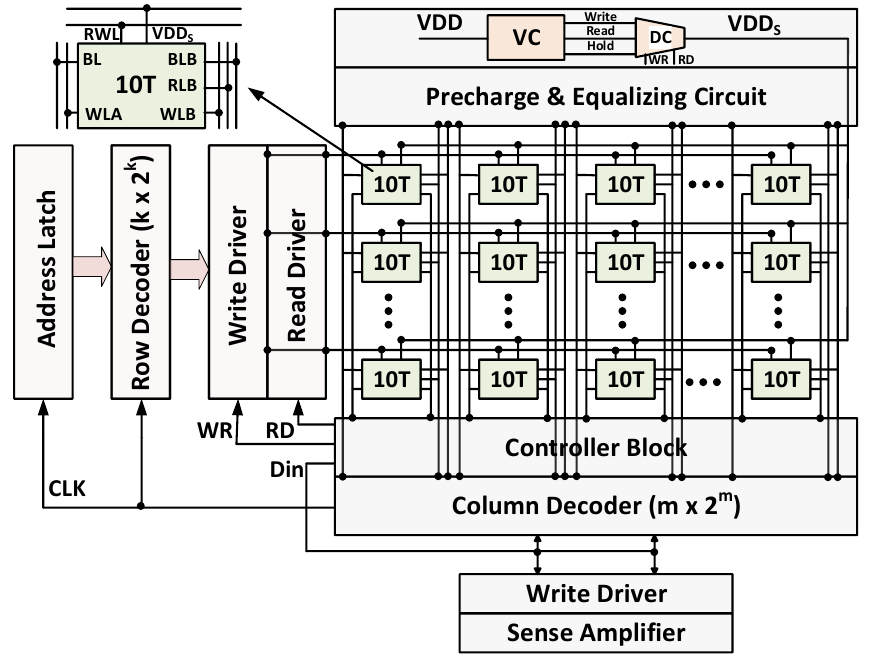
Figure 7. Proposed reconfigurable VDD (R-VDD) scaled memory architecture for the proposed D 2 LP10T SRAM